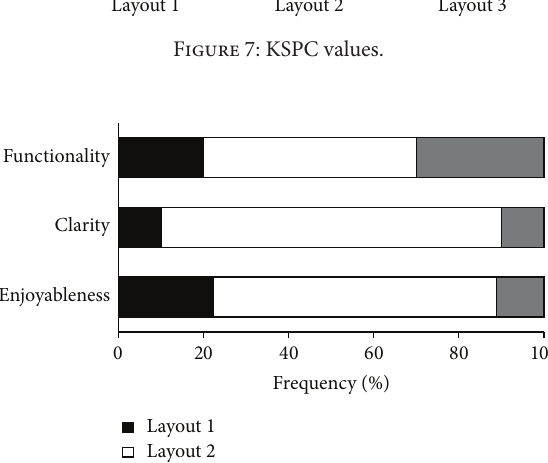
Figure 5: Text entry rate by cpm.